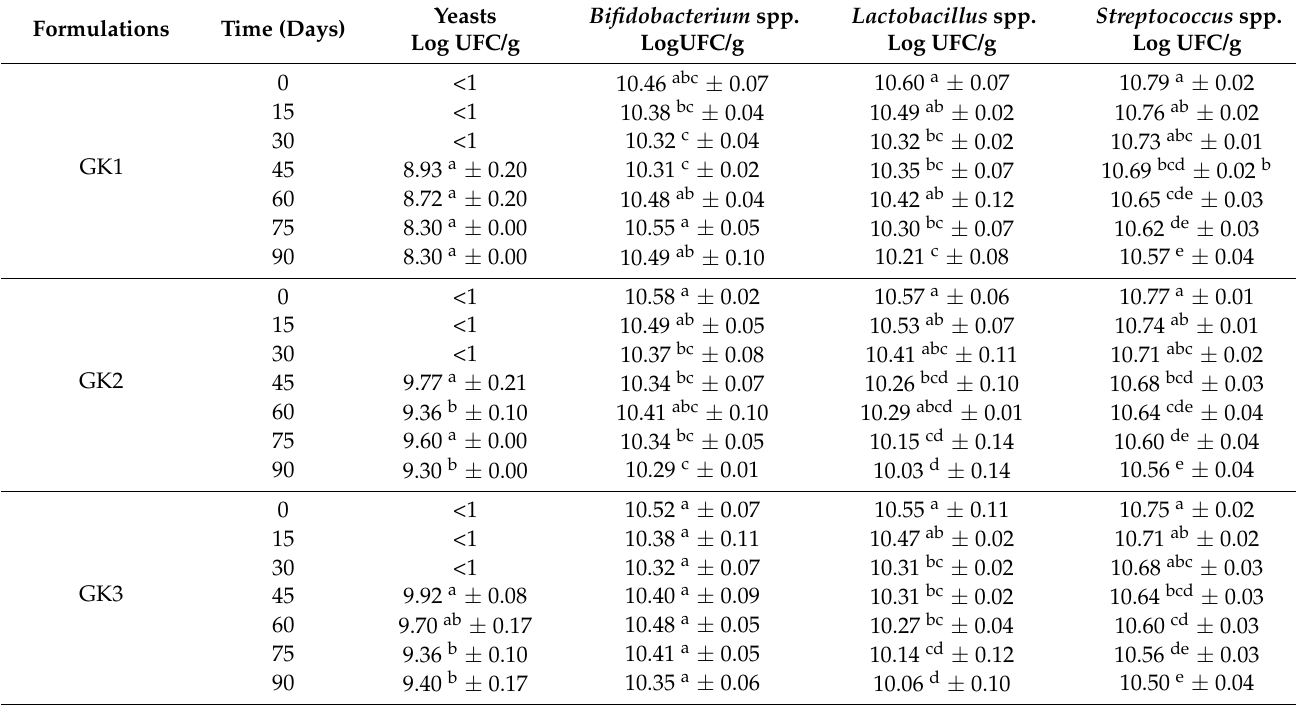
Table 2. Viability of yeasts, Bifidobacterium spp., Lactobacillus spp. and Streptococcus spp. in ice cream during storage at − 22 ◦ C ±